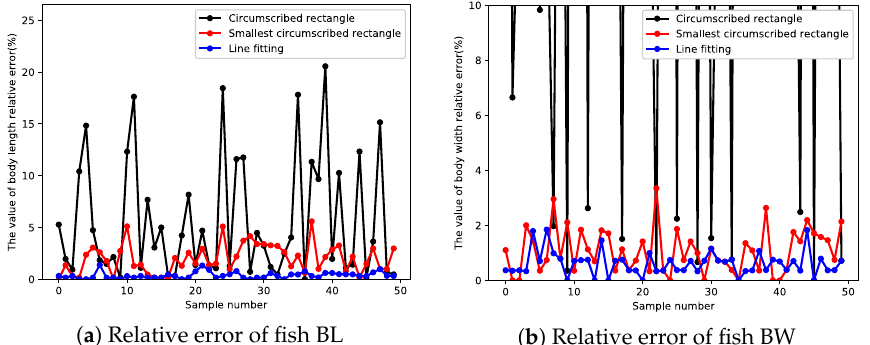
Figure 19. Comparison of relative measurement errors using improved U-net combined with three measurement methods.